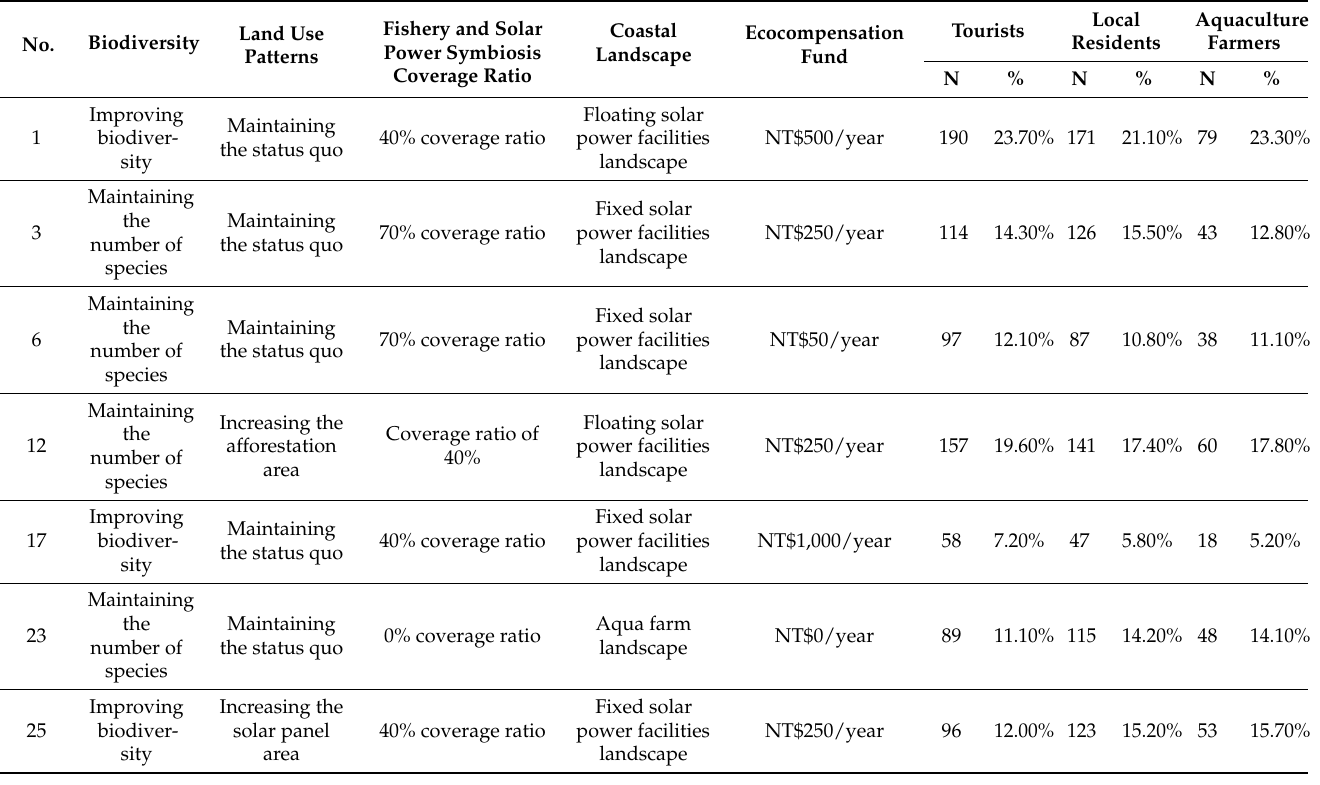
Table 5. Combination of respondents’